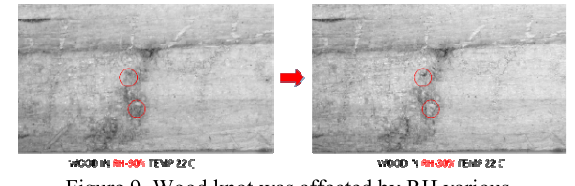
Figure 9. Wood knot was affected by RH various